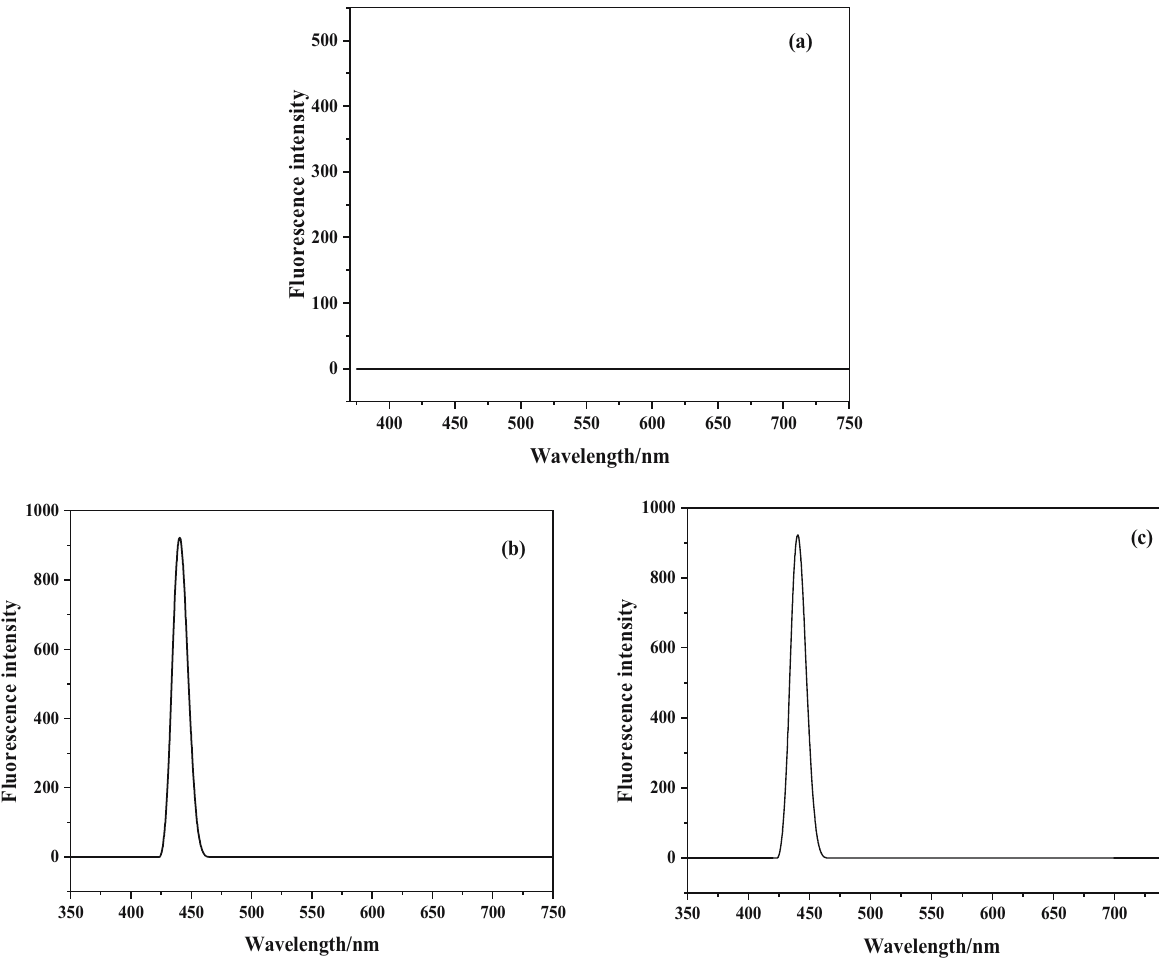
Figure 6: ( a ) Fluorescence map of blank solution, ( b ) fl uorescence system containing standard FEL solution, and ( c ) fl uorescence system containing sample FEL solution.